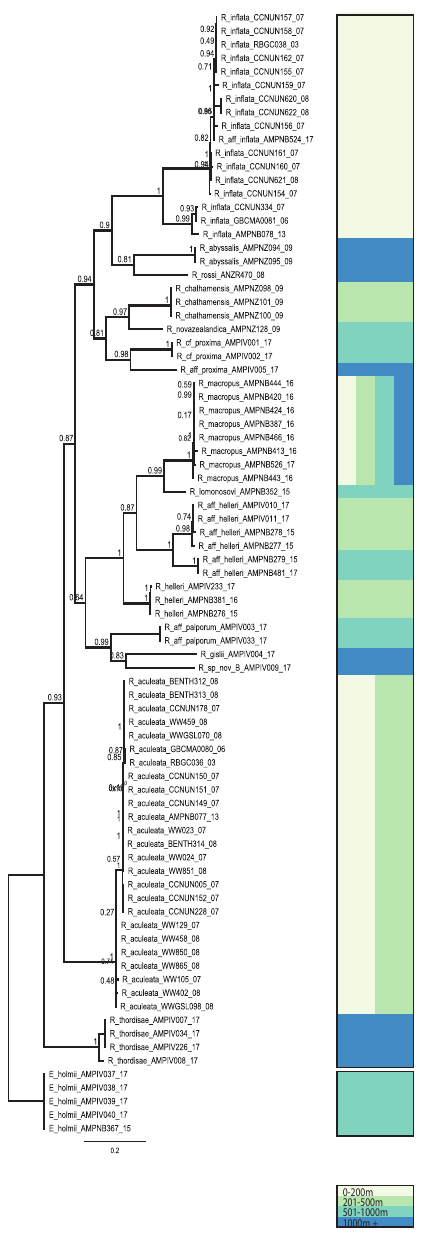
Figure 1. COI gene tree calculated with FastTree2 ver. 2.1.5 (Price et al. 2010) with the GTR plus gamma model and 20 rate categories of sites to estimate initial gene trees from the sequences. Support values were calculated for nodes with the Shimodaira-Hasegawa (Shimodaira and Hasegawa 1999) test and 1000 resamples. Samples via IceAGE, NorAmph and mined from Genbank (Details Supplementary Table 1). Clades are coloured for depth strata for sampling: 0–200 m light grey, 201–500 m light green, 501–1000 m turquoise, 1000+ m blue. A combination of vertical colours indicates a combination of depth